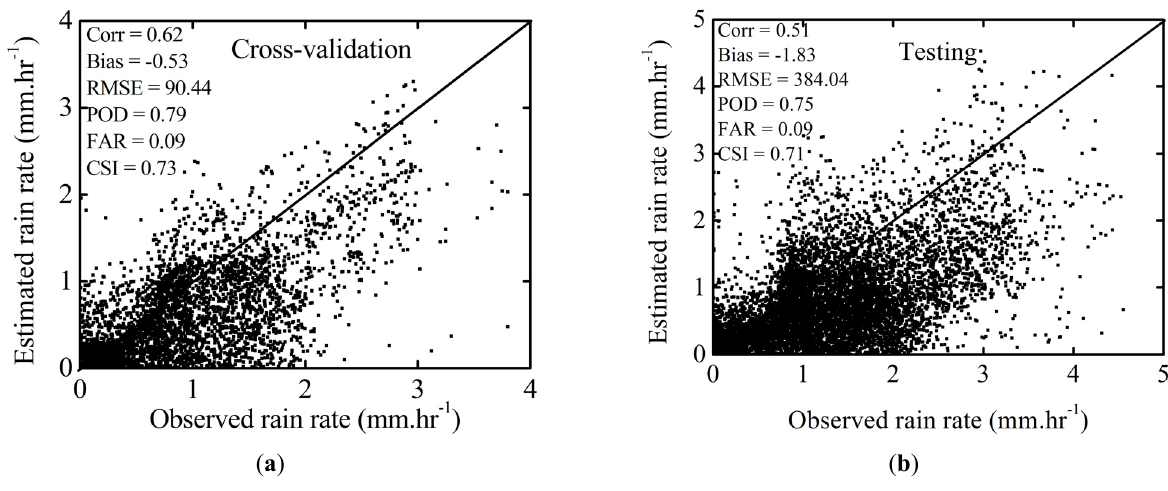
Figure 3. Scatter plot of the estimated rain rate vs. the observed rain rate of the gauge. ( a ) Cross-validation results with data from June to October 2007; ( b ) testing results with data of May 2007 and July